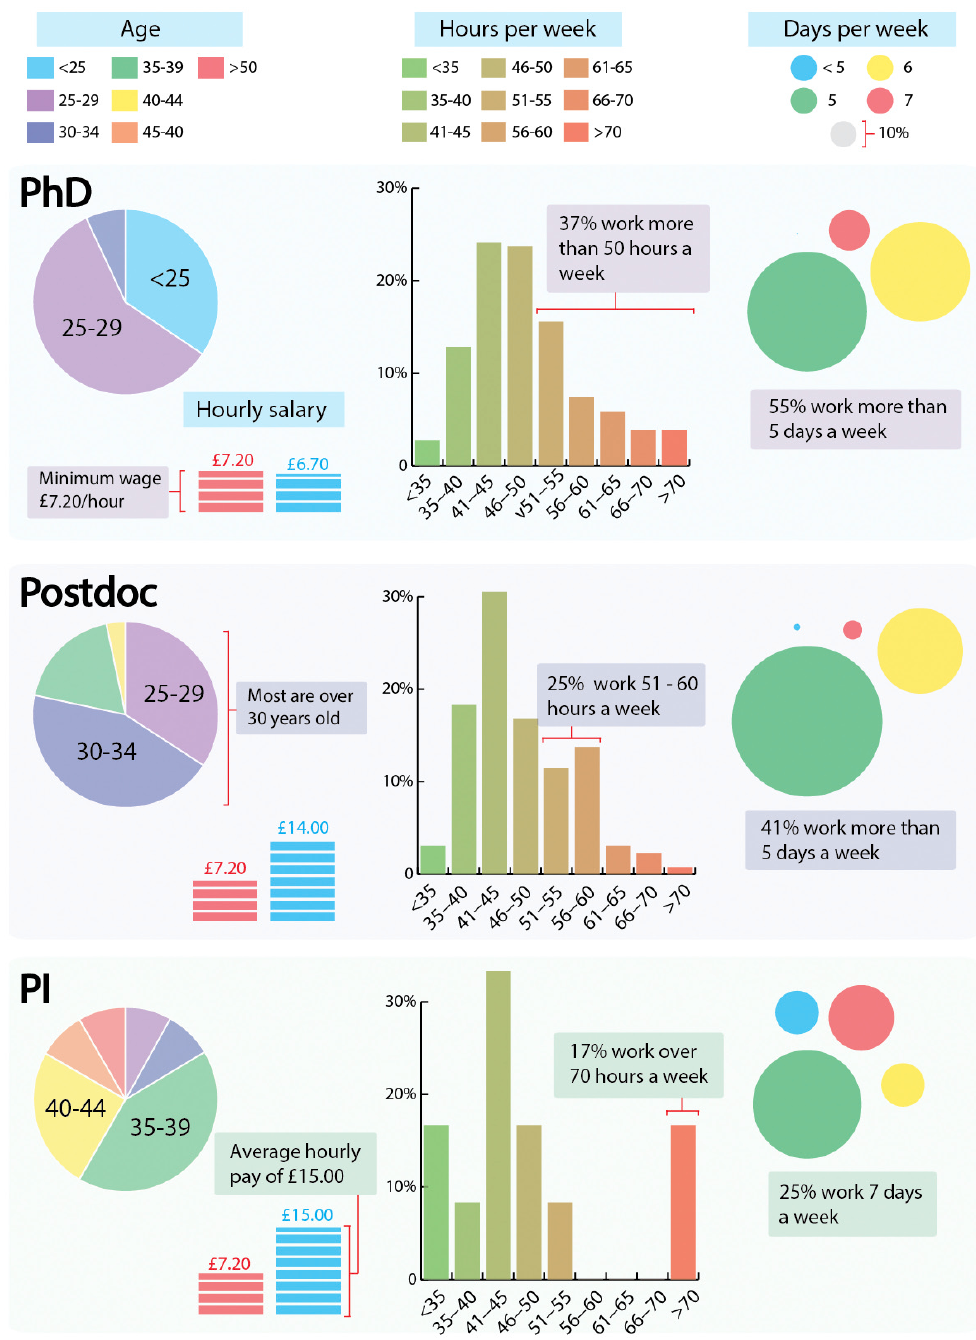
Figure 2. Graphical representation of analysed survey data. The data are presented for three discrete career stages, the PhD (as shown in light blue box ‘ PhD ’), the postdoc (light purple box ‘ postdoc ’) and the PI (light green box ‘ PI ’). Venn diagrams show the distribution of respondents per cohort across age categories, with each colour representing a discrete age range (light blue: younger than 25; purple: 25–29; dark blue: 30–34; green: 35–39; yellow: 40–44; orange: 45–50; red: older than 50). Hourly salaries are shown as stylised bar charts, where the height of the bar represents hourly salary. In each case, the average salary is shown in light blue, contrasted with the minimum hourly salary shown in red. The average number of hours worked per week for each group is represented as a bar chart. In each case, the percentage of respondents per category is shown plotted against the number of hours worked per week. The number of days worked per week are represented as bubbles for each group, where bubbles are coloured by category (blue: fewer than 5 days per week; green: 5 days per week; yellow: 6 days per week; red: 7 days per week). The size of each bubble represents the relative number of respondents per group in each category. The legend shows a reference bubble (coloured grey) representing a value of 10